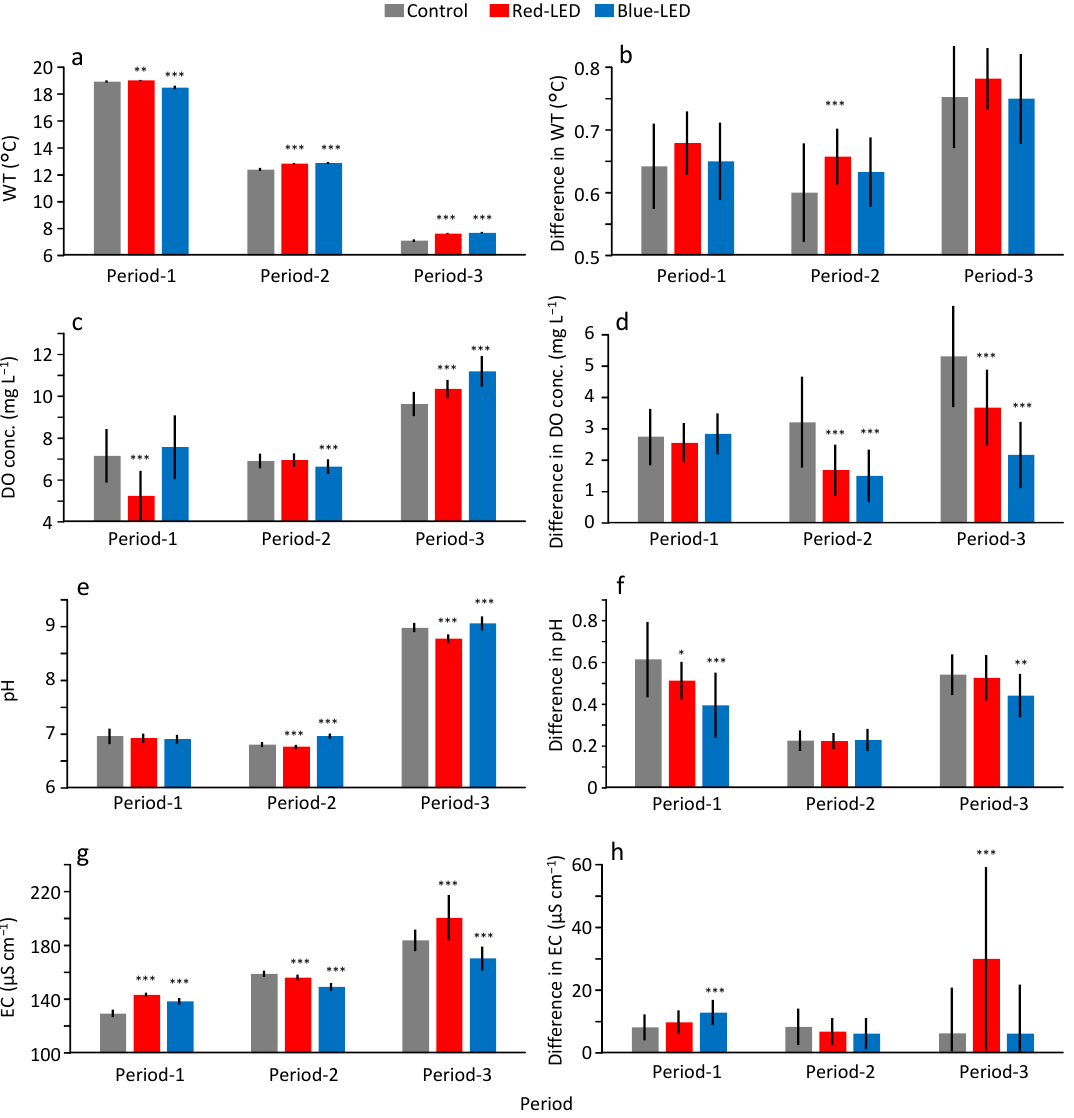
Figure 3. Differences in water quality of the depression between the control and LED treatments (( a ): daily mean temperature, ( b ): diel temperature change, ( c ): daily mean DO, ( d ): diel DO change, ( e ): daily mean pH, ( f ): diel pH change, ( g ): daily mean EC, ( h ): diel EC change). Error bars are SD of the difference from the mean each day. Asterisks show the significance of the difference between the control and LED treatment (*: p < 0.05, **: p < 0.01, ***: p < 0.001). The DO concentration was significantly lower in the red LED than in the control in period-1, slightly but significantly lower in the blue LED than in the control in period-2, and significantly higher in the red and blue LED than in the control in period-3 (Figure 3c). In period-3, the DO was 0.7 mg L − 1 and 1.5 mg L − 1 higher in the red and blue